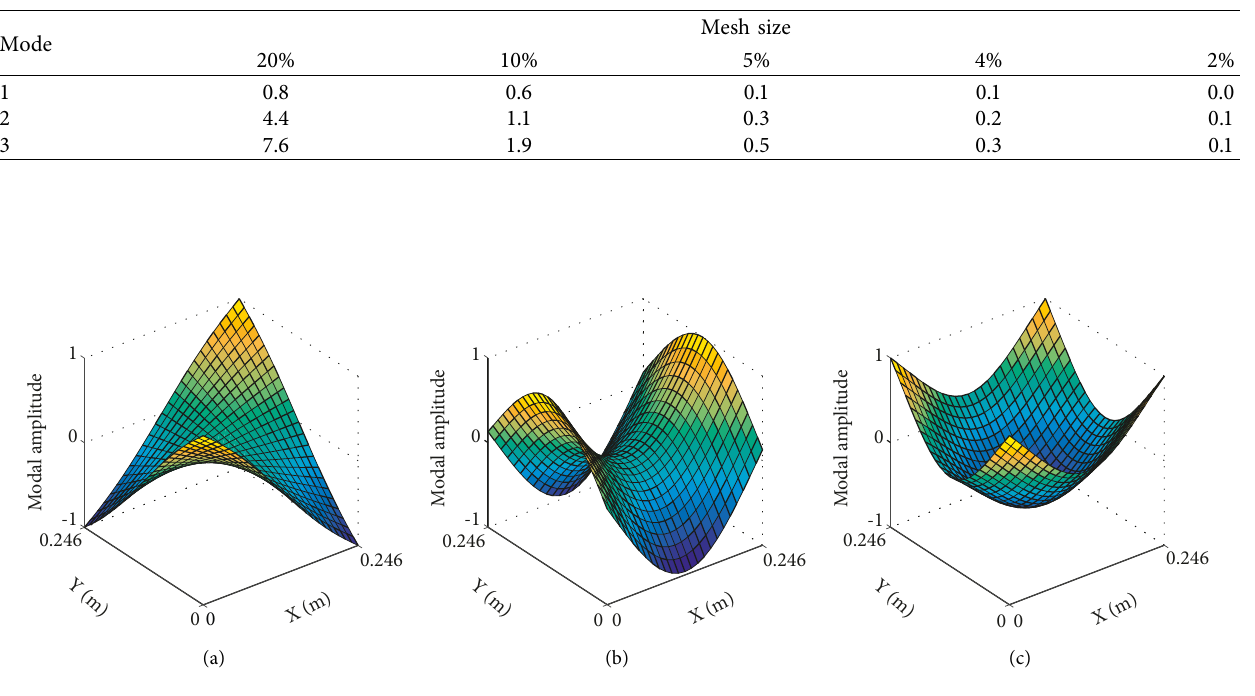
Table 2: Natural frequency convergence (%) in comparison to the plate dimension’s mesh size of